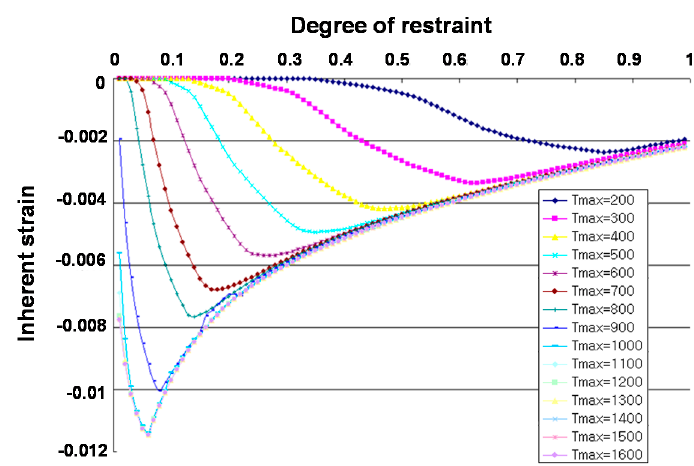
Figure 3. Inherent strain chart: butt welding.